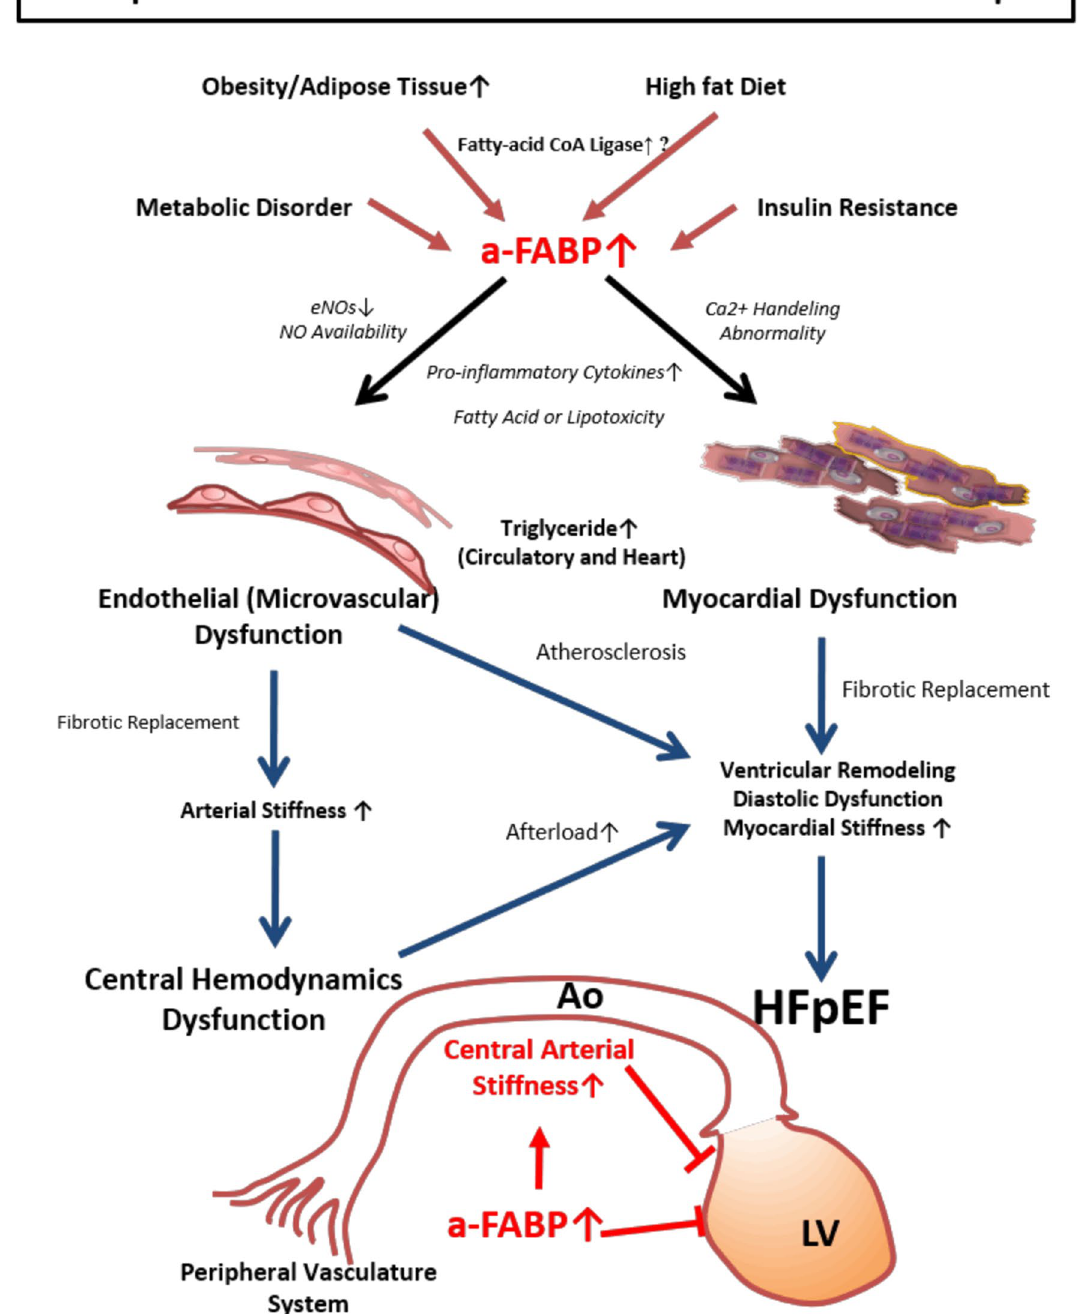
Figure 5. Role of a-FABP in the pathophysiology of heart failure. The hypothetical mechanistic links underlying higher a-FABP, micro-vascular dysfunction, and HFpEF are shown. Heightened central aortic stiffness and impaired myocardial function are key mediators in this pathological process. Ao, aorta, LV, left ventricle. Other abbreviations as Table